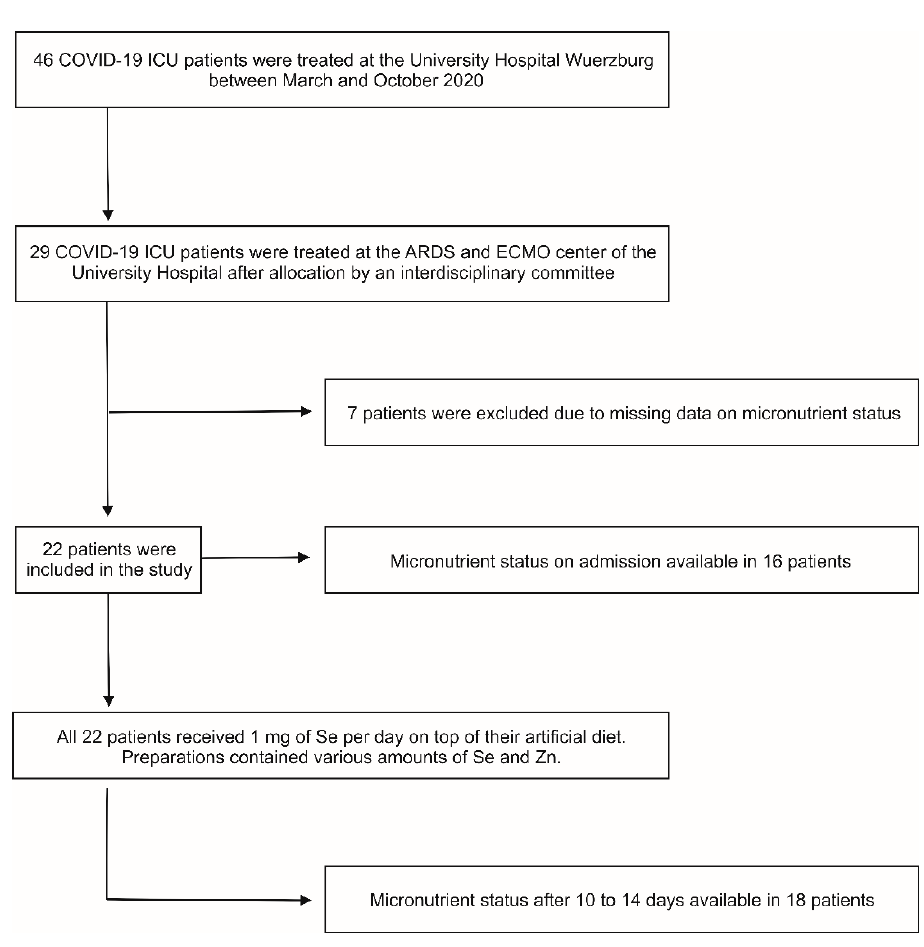
Figure 1. Flow diagram of retrospective study inclusion. All 22 patients received high-dose selenium (Se) as selenite and artificial diet, which additionally included various amounts of zinc (Zn). ARDS, acute respiratory distress syndrome; ECMO, extracorporeal membrane oxygenation; ICU, intensive care unit.